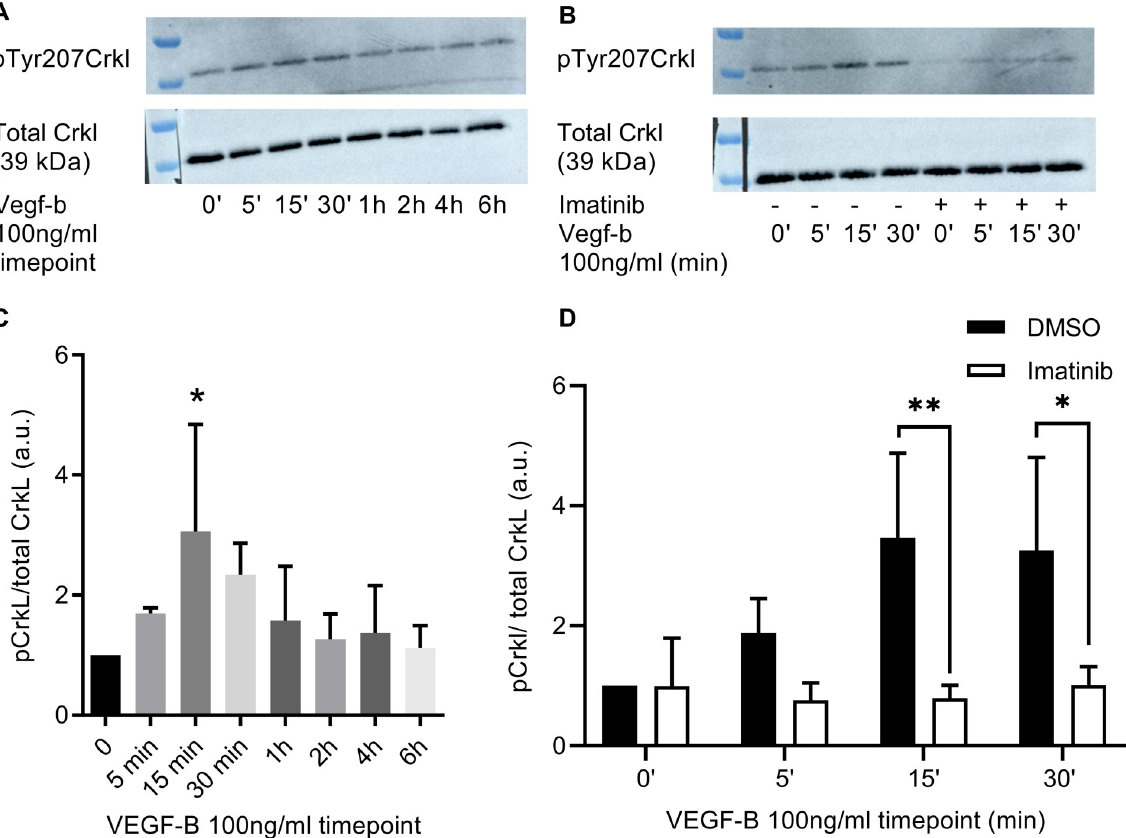
Fig 4. Effect of vascular endothelial growth factor-B (VEGF-B) and imatinib on Crk-like protein (CrkL) phosphorylation. A: Western blot images of VEGF-B-mediated phosphorylation of CrkL at different time points. C: Quantification of A. The phosphorylation of CrkL showed an increase at 15 min stimulation with VEGF-B. � P = 0.019 in Bonferroni post hoc test of repeated measures one-way ANOVA. B: Western blot images of the effect of imatinib on VEGF-B-mediated CrkL phosphorylation. D: Quantification of B. Imatinib attenuates the phosphorylation of CrkL in conditions with 15 and 30 min stimulation with VEGF-B. �� P < 0.01, � P < 0.05 in Bonferroni post hoc test of repeated measures two-way ANOVA. a.u. = arbitrary units; n = 3. For uncropped blot images see S1 Fig.